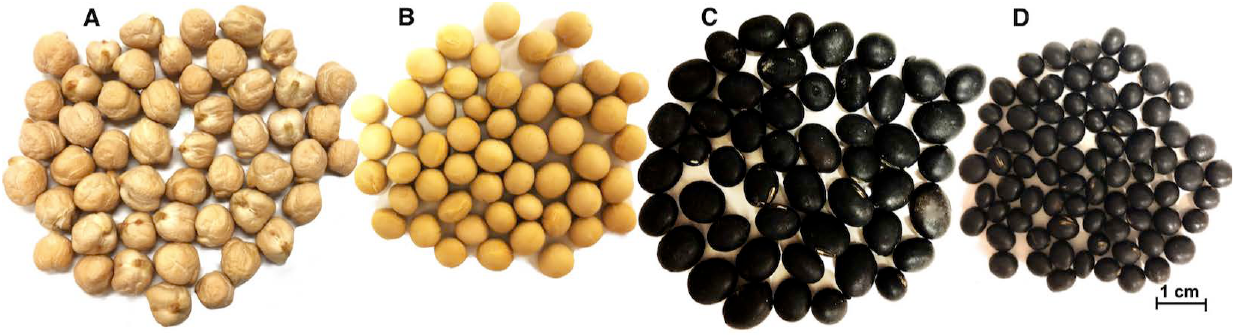
Figure 1. Images of the clean dried seeds used in the AQ production obtained (10 magnification) with a Canon Eos 300D digital camera mounted on a Zeiss Stemi SV 11 light microscope. The images were subsequently processed in Adobe Photoshop 2021 v22.4.3. ( A ) CDC Leader, ( B ) Backtae, ( C ) Seoritae, ( D ) Jwinunikong.